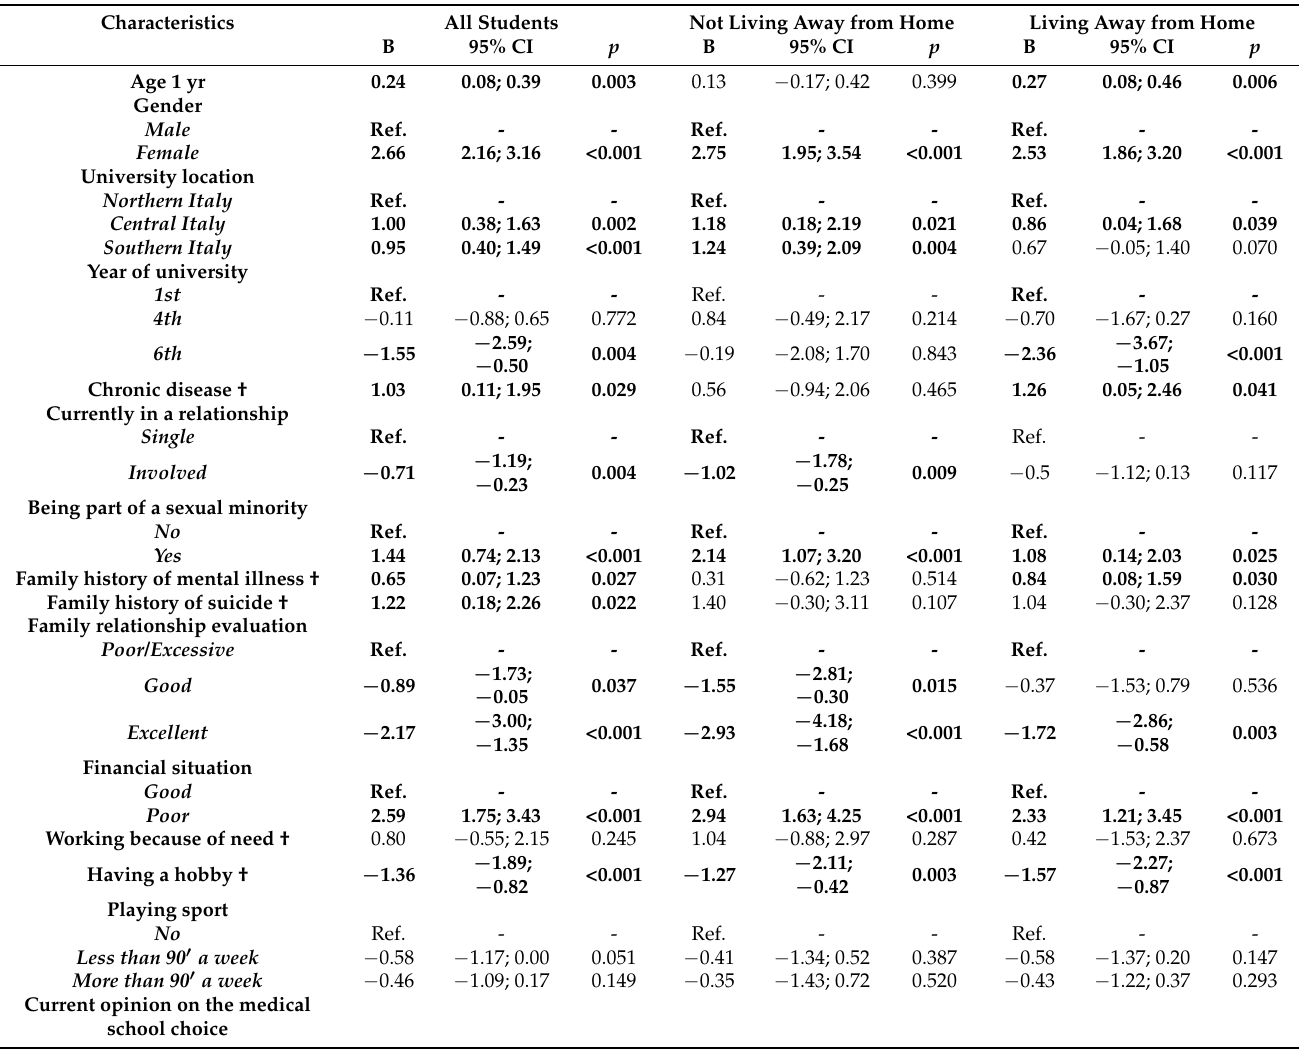
Table 3. Characteristics associated with perceived stress, stratified by living